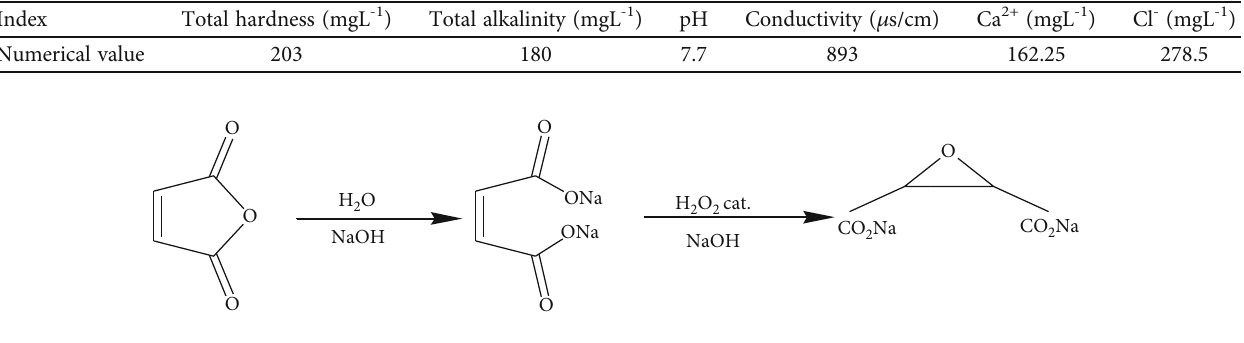
Figure 1: Reaction equation of epoxysuccinic acid (ESA) synthesis [11].